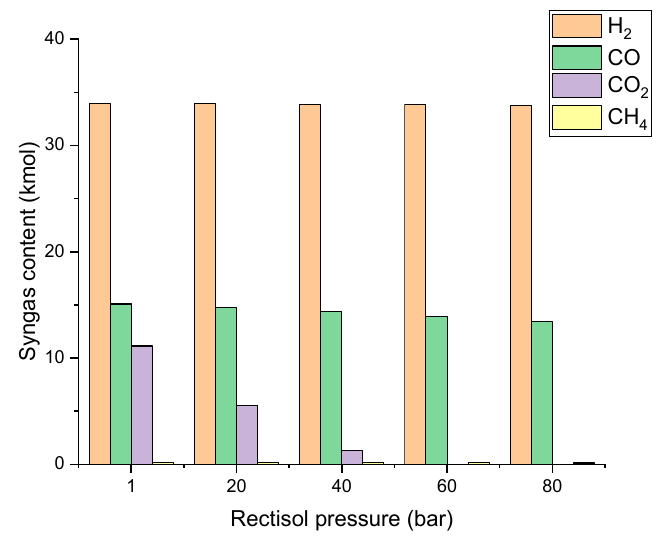
Figure 8. E ff ect of Rectisol pressure on syngas composition ( − 20 ◦ C). Figure 8. Effect of Rectisol pressure on syngas composition ( − 20 °C).